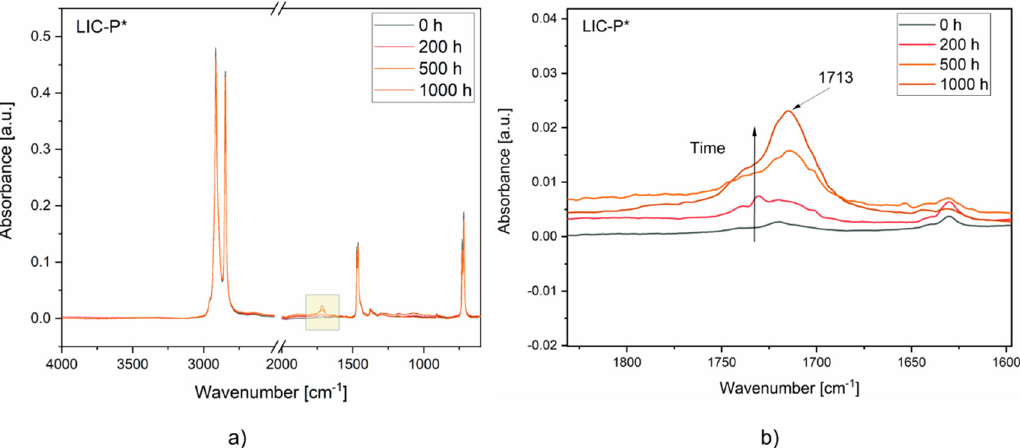
Figure 13. FTIR spectra of the coatings at different exposure times to UV irradiation: ( a ) LIC-P* spectra, ( b ) LIC-P* spectra enlarged in the region of interest. The spectra region is highlighted by a yellow box when chemical modifications are detected.